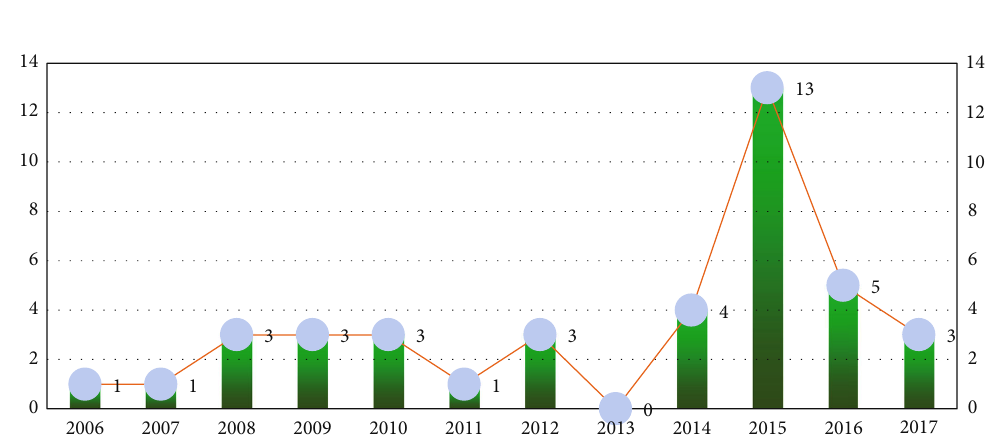
Figure 4: Innovation and entrepreneurship policies of higher vocational colleges under the background of big intelligence shifting to cloud.